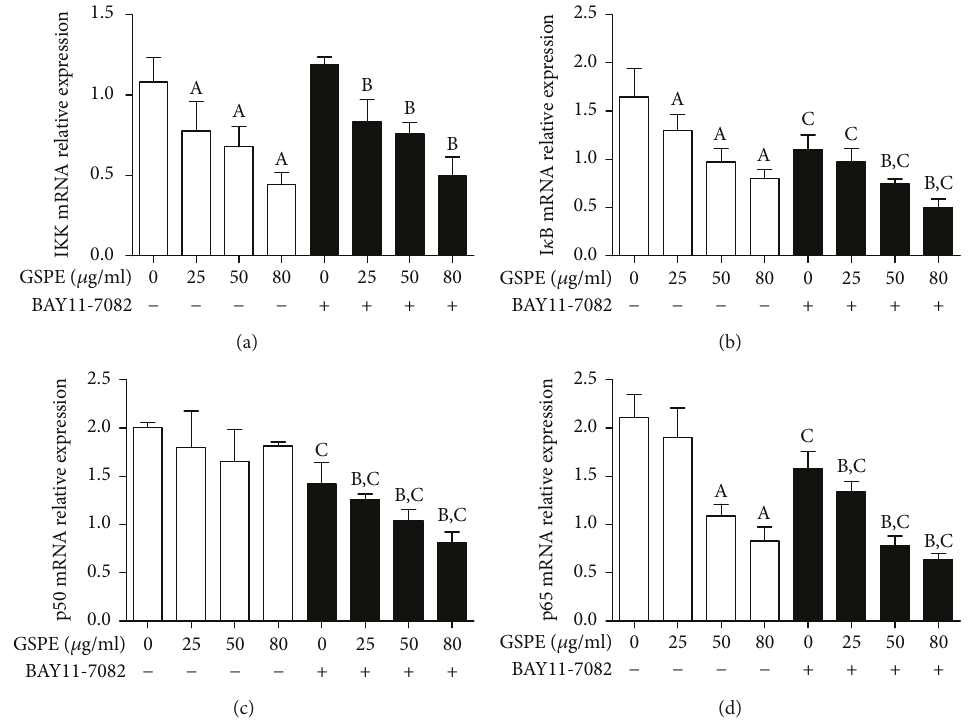
Figure 8: The e ff ects of GSPE and BAY11-7082 on the expression of IKK, I κ B, p50, and p65 mRNA in ECA109 cells. (a) The inhibition of IKK mRNA expression by GSPE (0 – 80 μ g/mL) and BAY11-7082 (10 μ mol/L). (b) The inhibition of I κ B mRNA expression by GSPE (0 – 80 μ g/ mL) and BAY11-7082 (10 μ mol/L). (c) The inhibition of p50 mRNA expression by GSPE (0 – 80 μ g/mL) and BAY11-7082 (10 μ mol/L). (d) The inhibition of the p65 mRNA by GSPE (0 – 80 μ g/mL) and BAY11-7082 (10 μ mol/L). Each column represents the mean ± SD of three groups of independent samples. A P < 0 05 compared with the GSPE 0, BAY11-7082; B P < 0 05 compared with the GSPE 0, BAY11-7082+ group; C P < 0 05 compared with the BAY11-7082